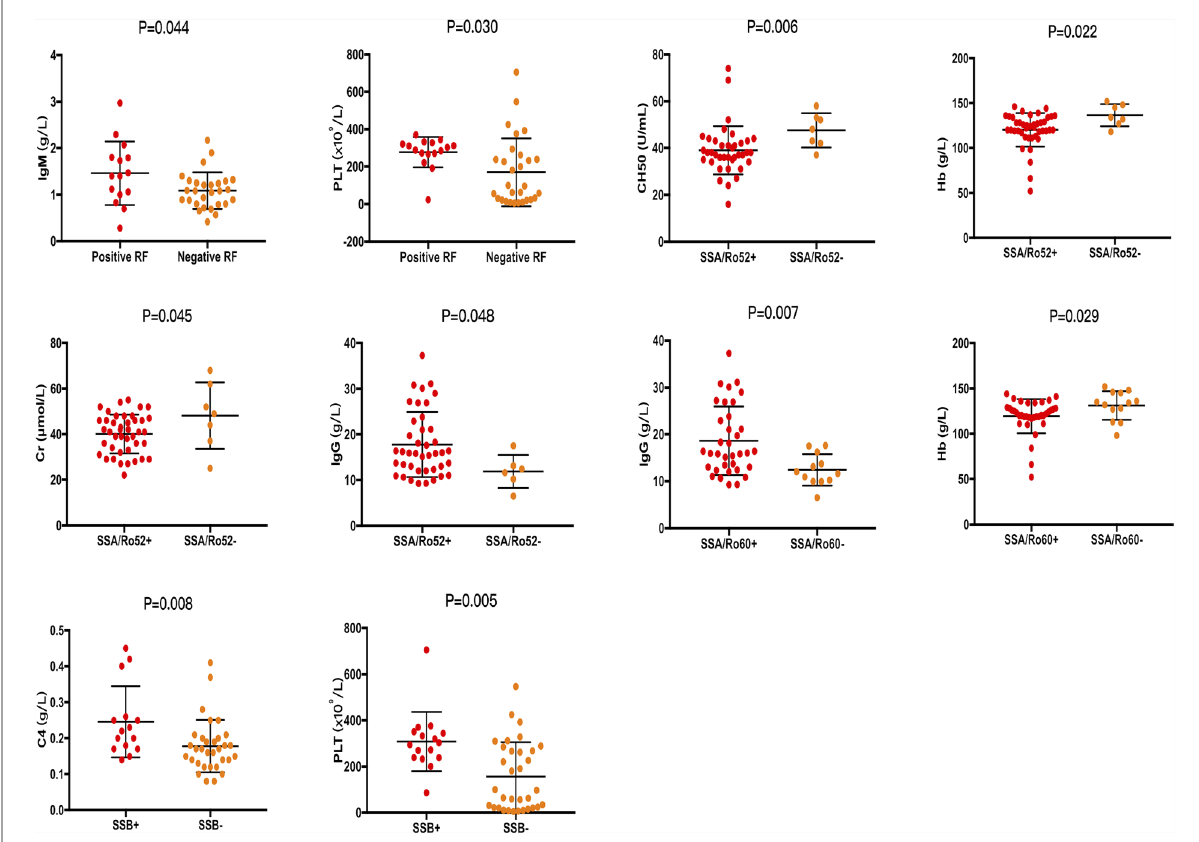
FIGURE 2 Laboratory features associated with patients with positive SSA/Ro52, positive SSA/Ro60, and positive SSB. ANA, anti-nuclear antibodies; SSA/Ro52, anti-Ro52/SSA antibodies; SSA/Ro60, anti-Ro60/SSA antibodies; SSB, anti-Ro/SSB antibodies; RF, rheumatoid factor; C4, complement 4; CH50, complement total activity; IgG, immunoglobulin G; IgM, immunoglobulin M; Hb, hemoglobin; PLT, platelets; Cr,